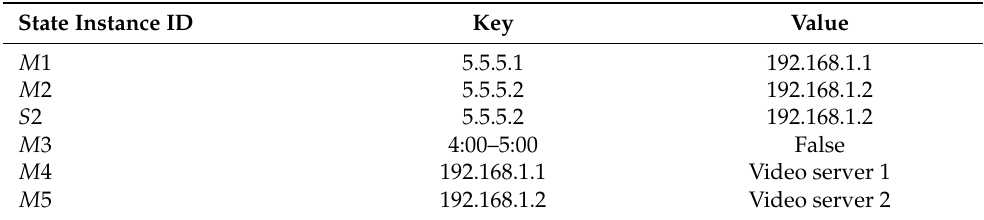
Table 2. Written and read state instances by the NFs of Figure